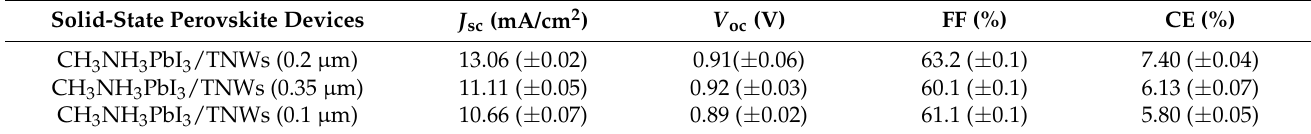
Figure 3. ( a , b ) J - V characteristics (forward sweep) and dark current of prepared solid state devices, ( c ) IPCE with the influence of changing length of the TNWs, and ( d ) Mott-Schottky plots to extract the V bi of the solid-state hybrid devices. Table 1. Photovoltaic performance of the solid-state perovskite devices with TNWs. Solid-State Perovskite